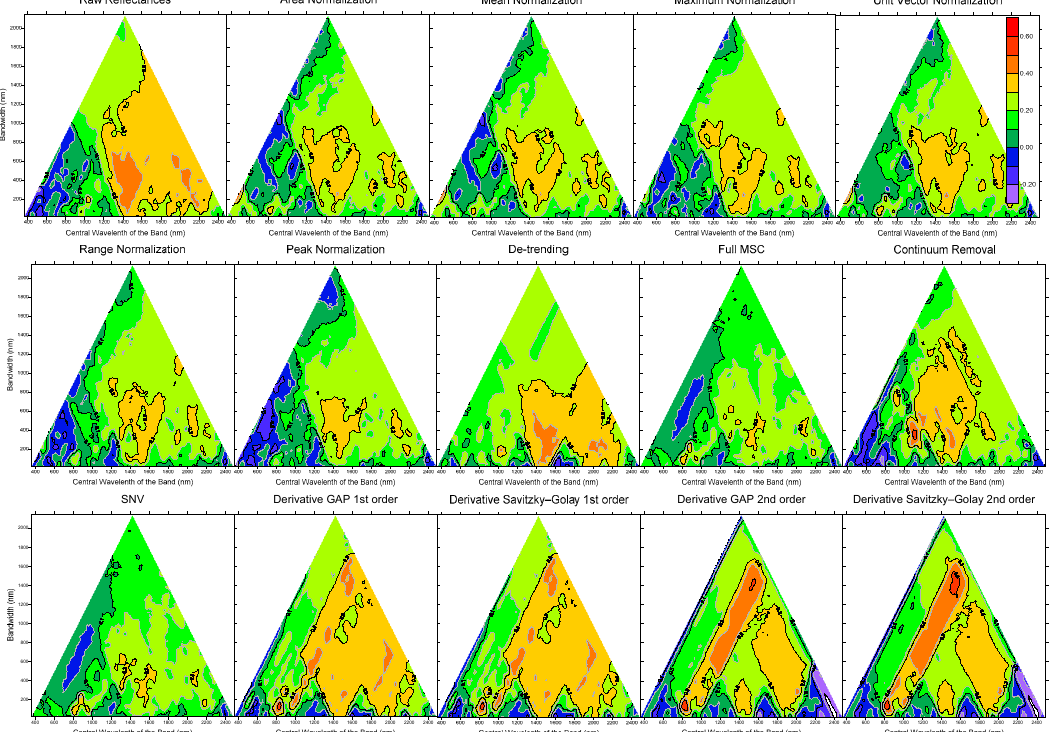
Figure 9. R 2 values obtained by PLSR using raw reflectance data and after pre-processing (area, mean, maximum, unit vector, range, and peak variants of normalization, de-trending, MSC, CR, SNV, and GAP and Savitzky-Golay first- and second-order derivatives). All graphs apply the same colour scale (see legend in the top-right corner).